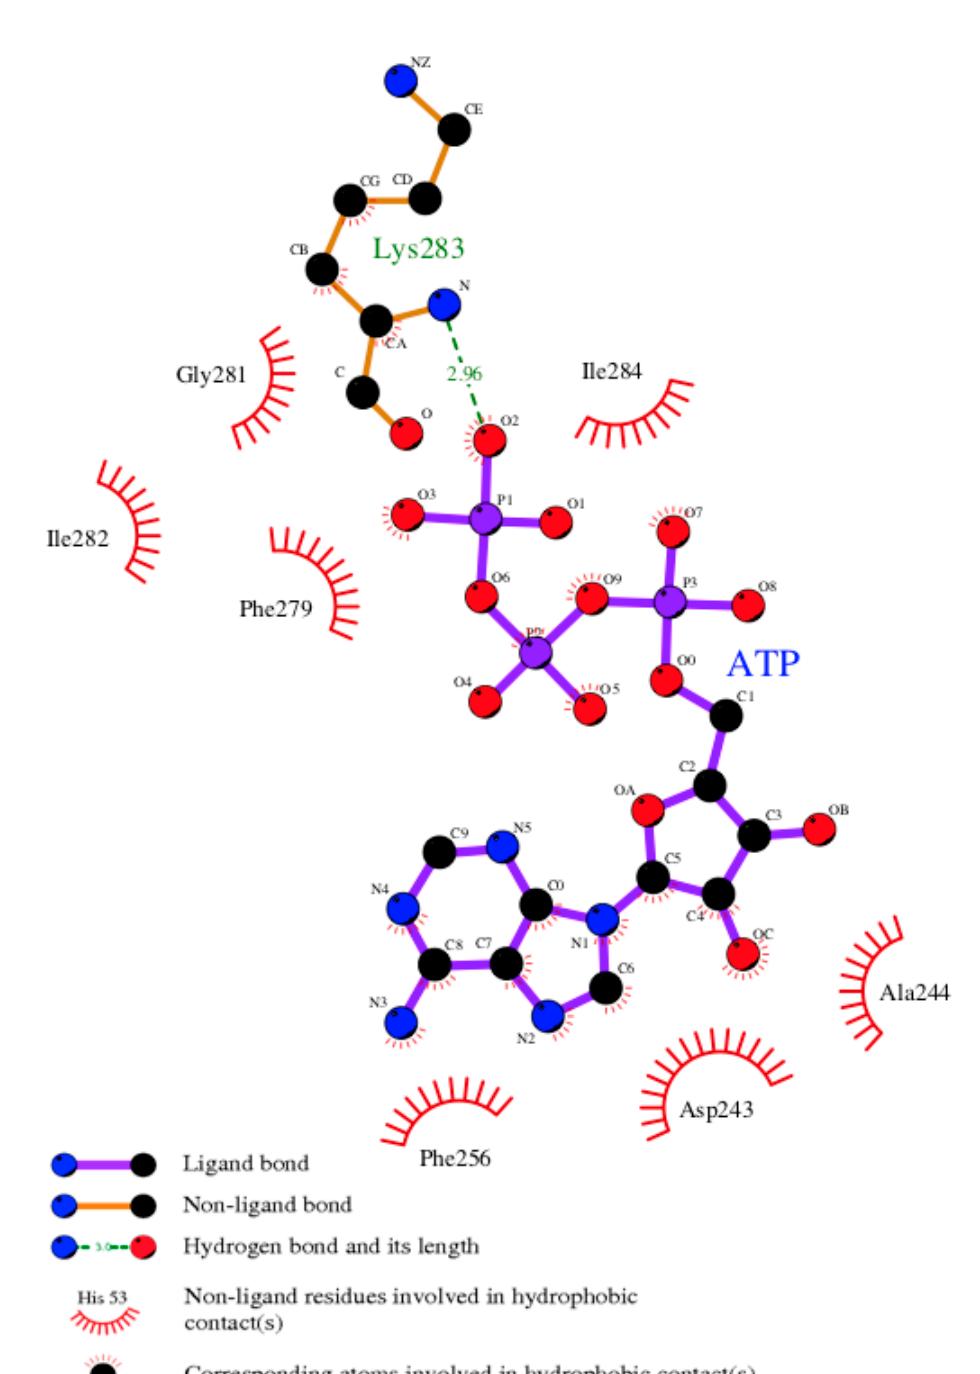
Figure 7. Ligand-protein contacts in the pUL15-ATP complex. Residues in the modeled pUL15 binding pocket interacting with the docked ATP molecule are shown. The various types of bonds are indicated in the figure legend.